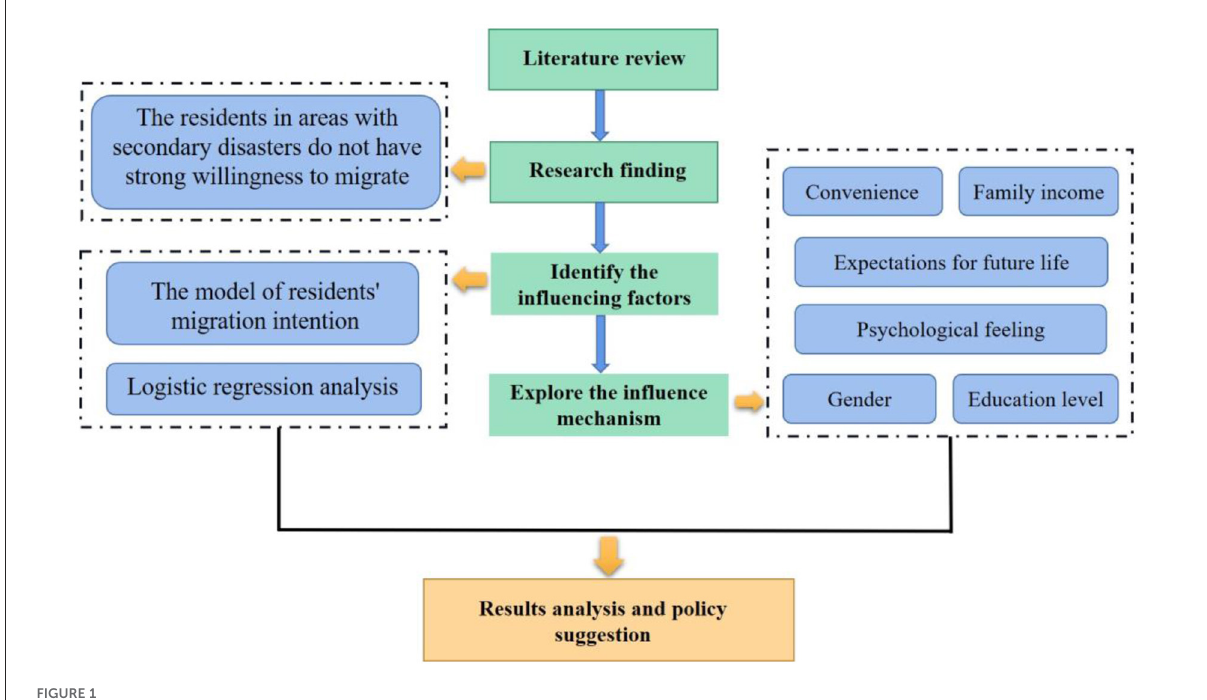
FIGURE1 The logical